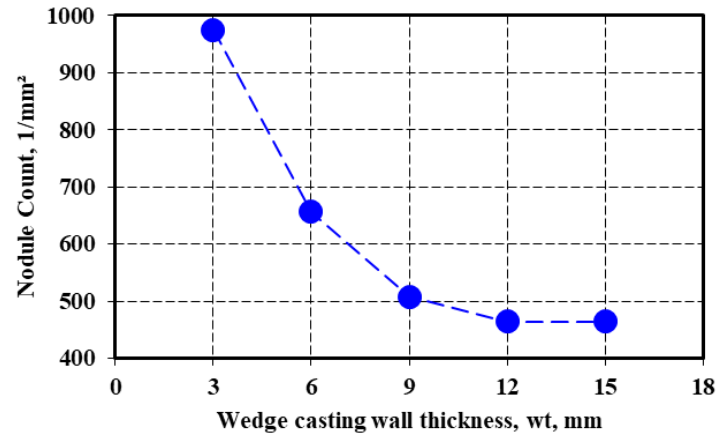
Figure 6. Influence of wedge casting wall thickness on the nodule count.